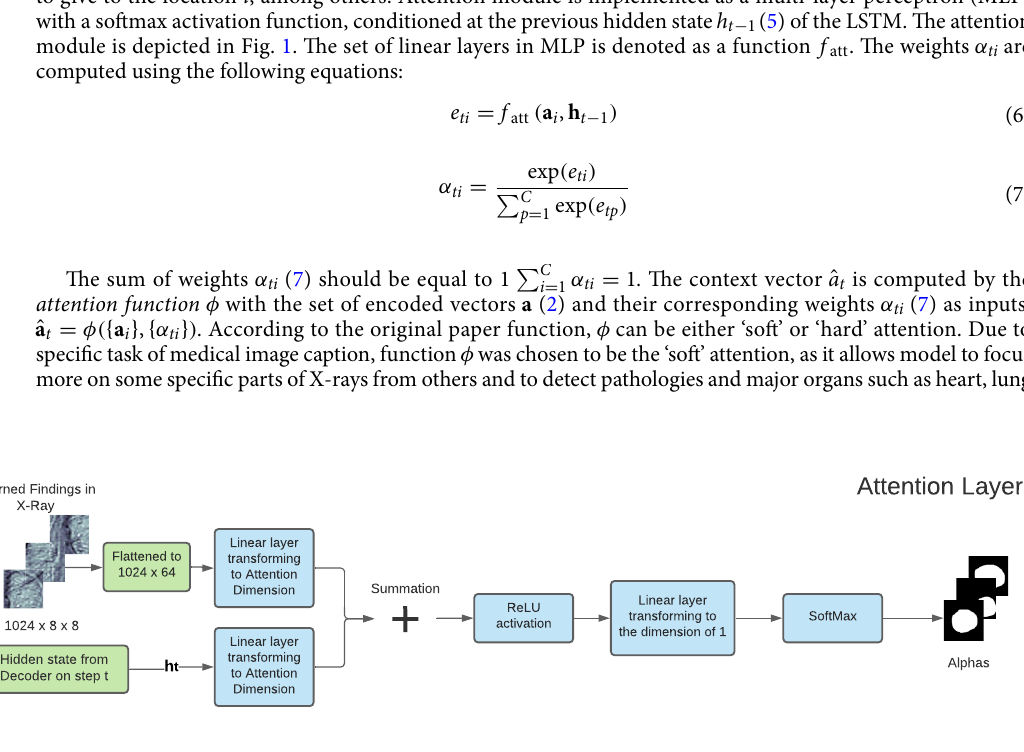
Figure 1. Attention module used in